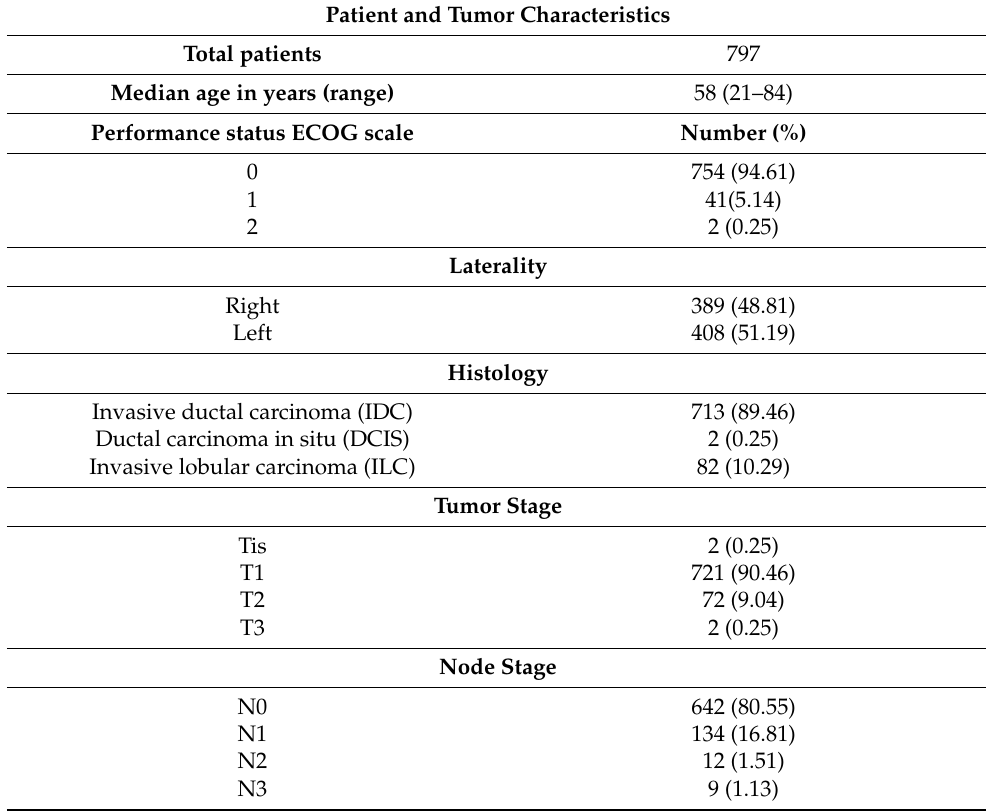
Table 2. Patient and tumor characteristics of the study